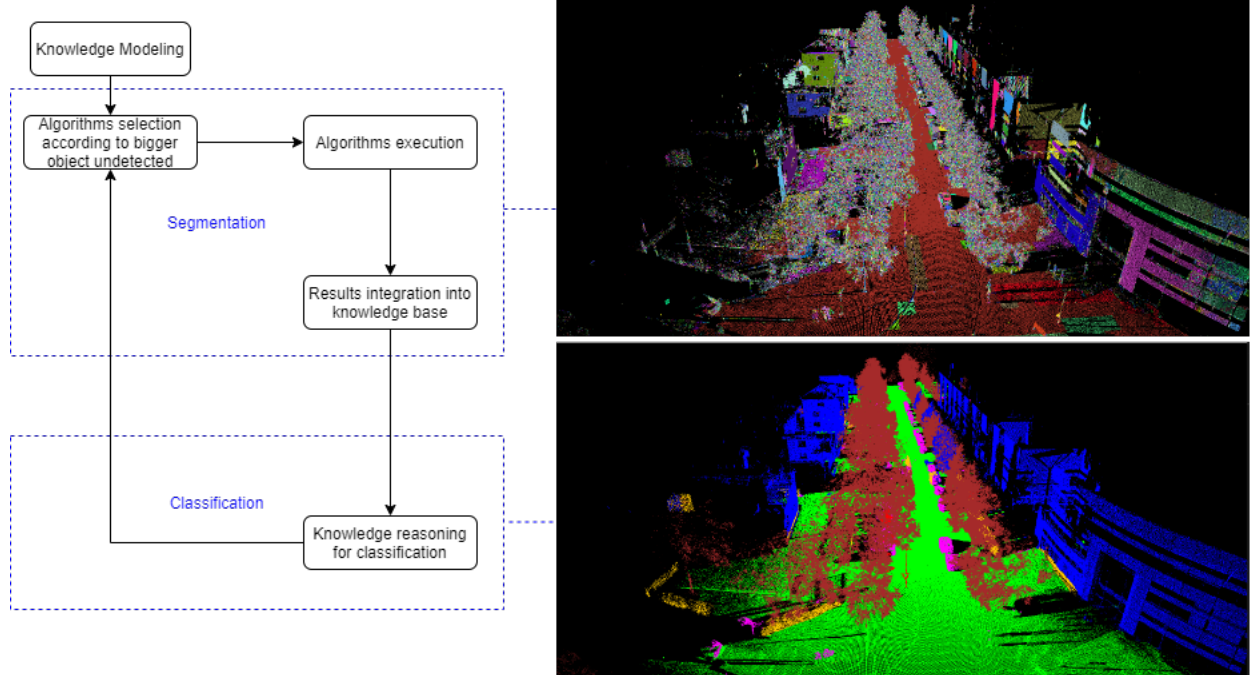
Figure 3. Overview of knowledge